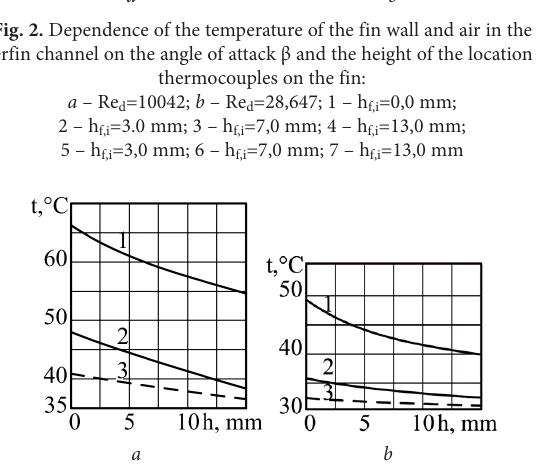
Fig. 3. Change of the fin and air temperatures averaged over the angle of attack β in the interfin channel along its height in the fifth row of the six-row bundle: a – Re d d=10042; b – Re d =28,647; 1 – fin temperature; 2 – air temperature; 3 – air temperature after mixing the flows from the interfin and intertubular